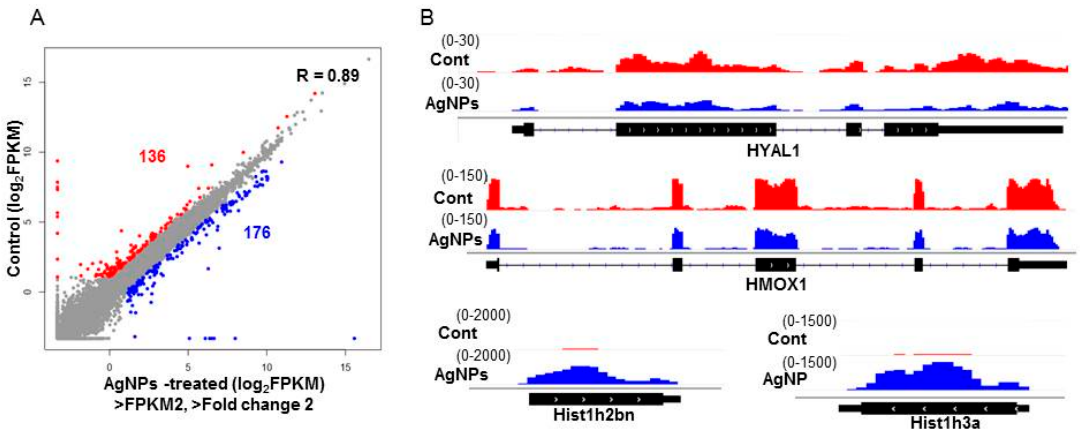
Figure 11. AgNPs administration changes gene expression. ( A ) A scatter plot showing genes up- or downregulated by AgNP treatment. Note that 136 and 176 genes were down- (red) and upregulated (blue), respectively. The log 2 FPKM values were used for plotting. Cutoff value: FPKM >2 and fold change (FC) >2. ( B ) IGV tracks of representative up- (HIST1H2BN and HIST1H3A) and downregulated genes ( HYAL1 and HMOX1 ).